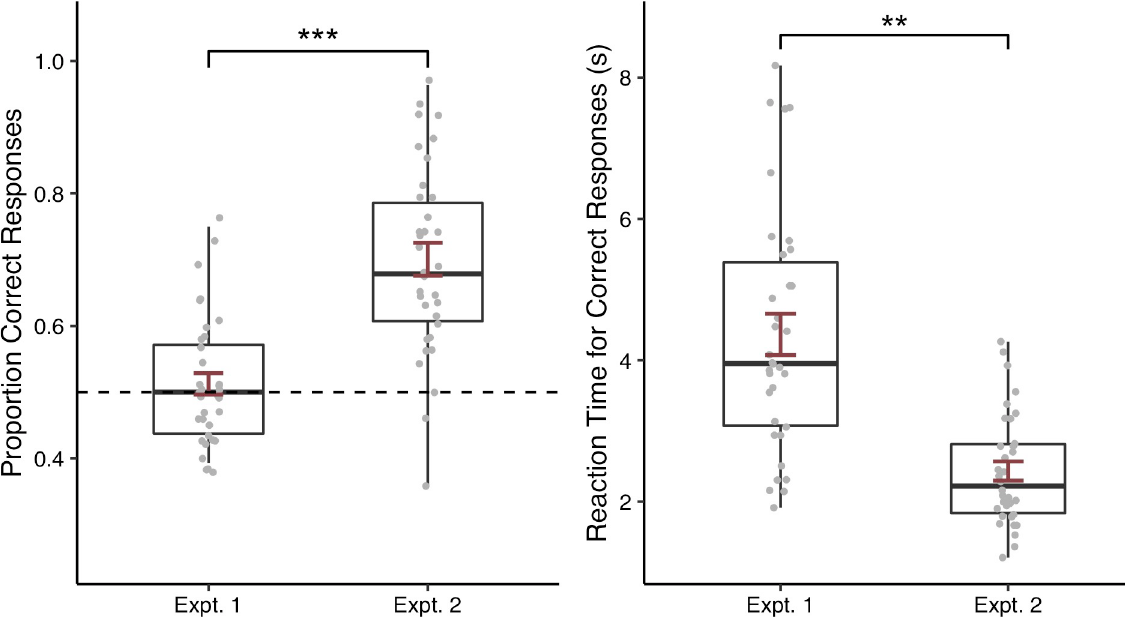
Fig 8. Proportion of correct responses (left) and reaction time (right) at test by participants in the explicit word learning condition in Experiment 1 and Experiment 2. Error bars represent one standard error. �� p < .01; ��� p < .001.